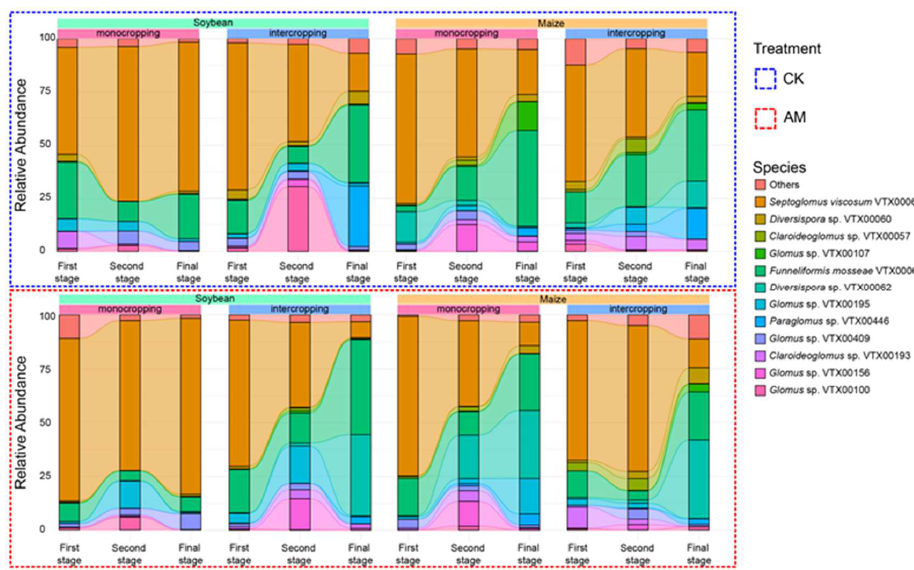
Figure 3. Column chart of the proportion of AMF species.